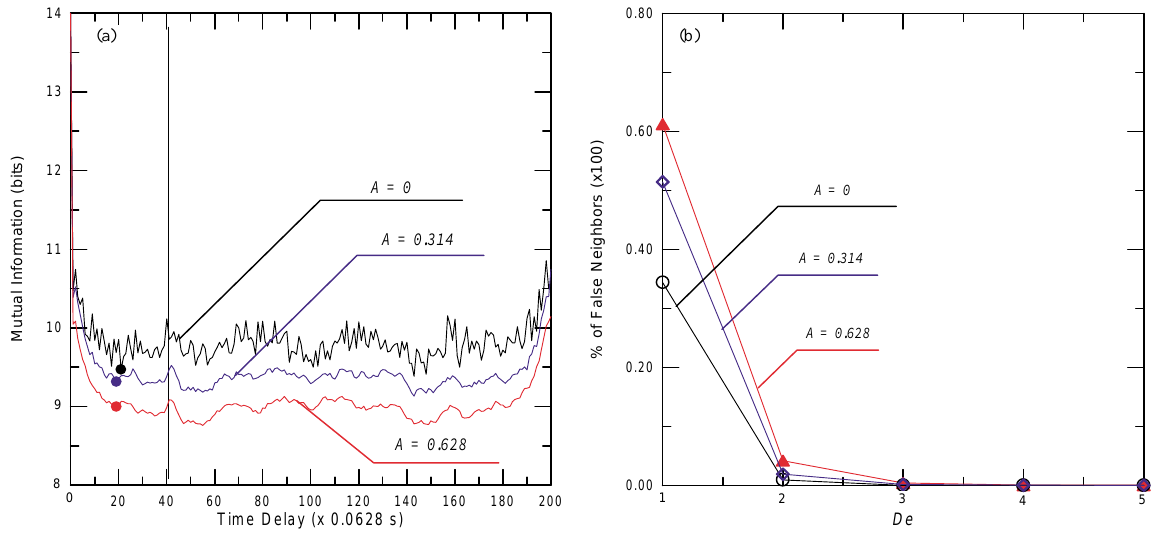
Fig. 3. Period-2 signal. (a) Mutual information versus time delay; (b) Percentage of false neighbors versus embedding dimension. Tangent space methods seem to be most promising for the calculation of the Lyapunov spectrum from time series. The product of the Jacobians along the trajec- tory can determine the spectrum of Lyapunov